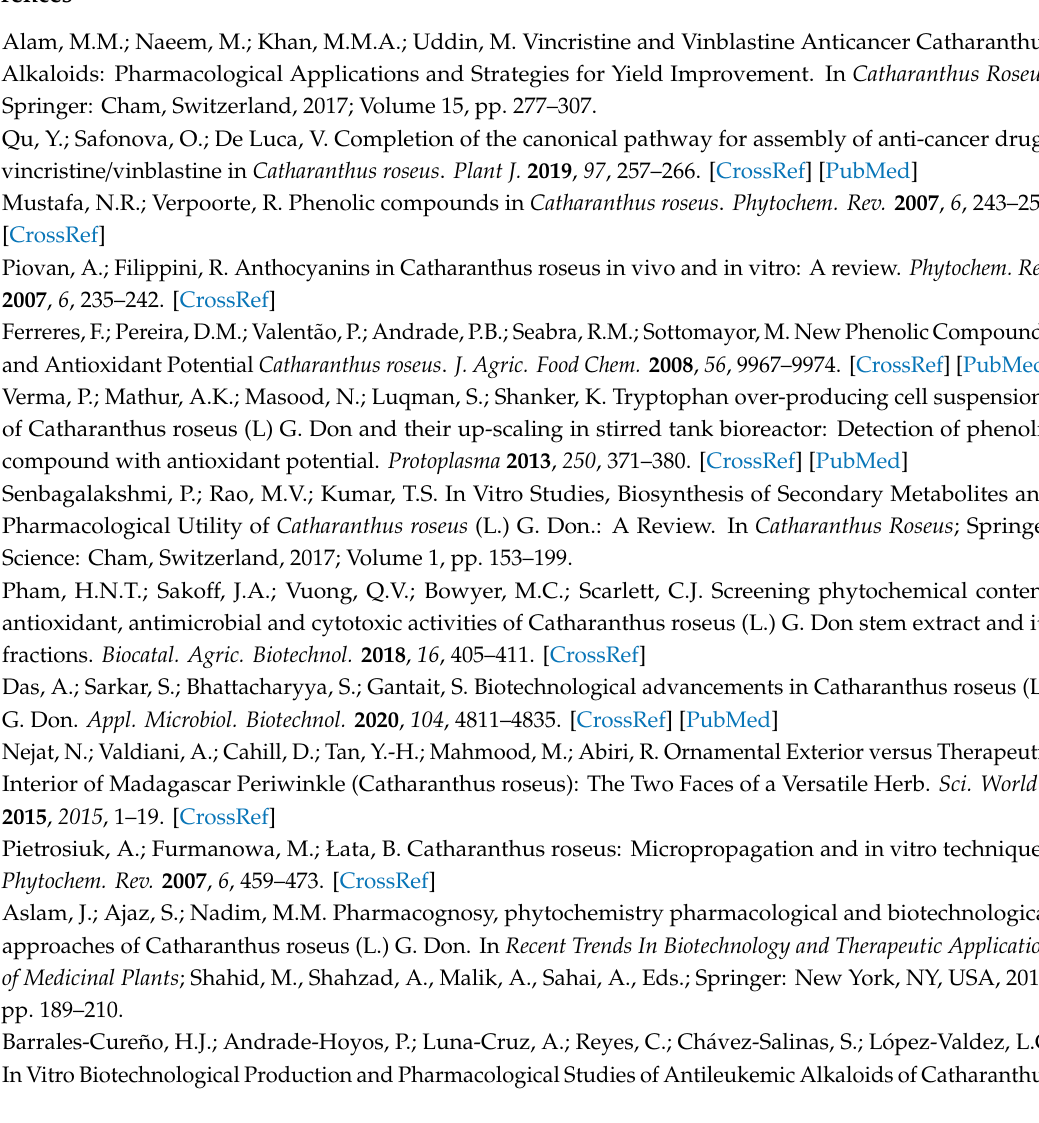
Supplementary Materials: Supplementary Materials are available online. Figure S1: Total ion chromatogram of the albino shoot sample in positive mode; Figure S2: Total ion chromatogram of the albino shoot sample in positive mode in 13–28 min; Figure S3: Total ion chromatogram of albino shoot sample in negative mode; Figure S4: Total ion chromatogram of callus sample in positive mode; Figure S5: Total ion chromatogram of callus sample in positive mode in 11–28 min; Figure S6: Total ion chromatogram of callus sample in negative mode; Figure S7: Total ion chromatogram of the normal-green shoot sample in positive mode; Figure S8: Total ion chromatogram of the normal-green shoot sample in a positive mode in 14–28 min; Figure S9: Total ion chromatogram of the normal-green shoot sample in negative mode; Figure S10: The typical extracted ion chromatogram ( m / z 337.1916) in positive ion mode; Figure S11: MS2 spectrum of Catharantine at retention time 21.76 min; Figure S12: The typical extracted ion chromatogram ( m / z 427.2233) in positive ion mode; Figure S13: MS2 spectrum of Vindolidine at retention time 25.23